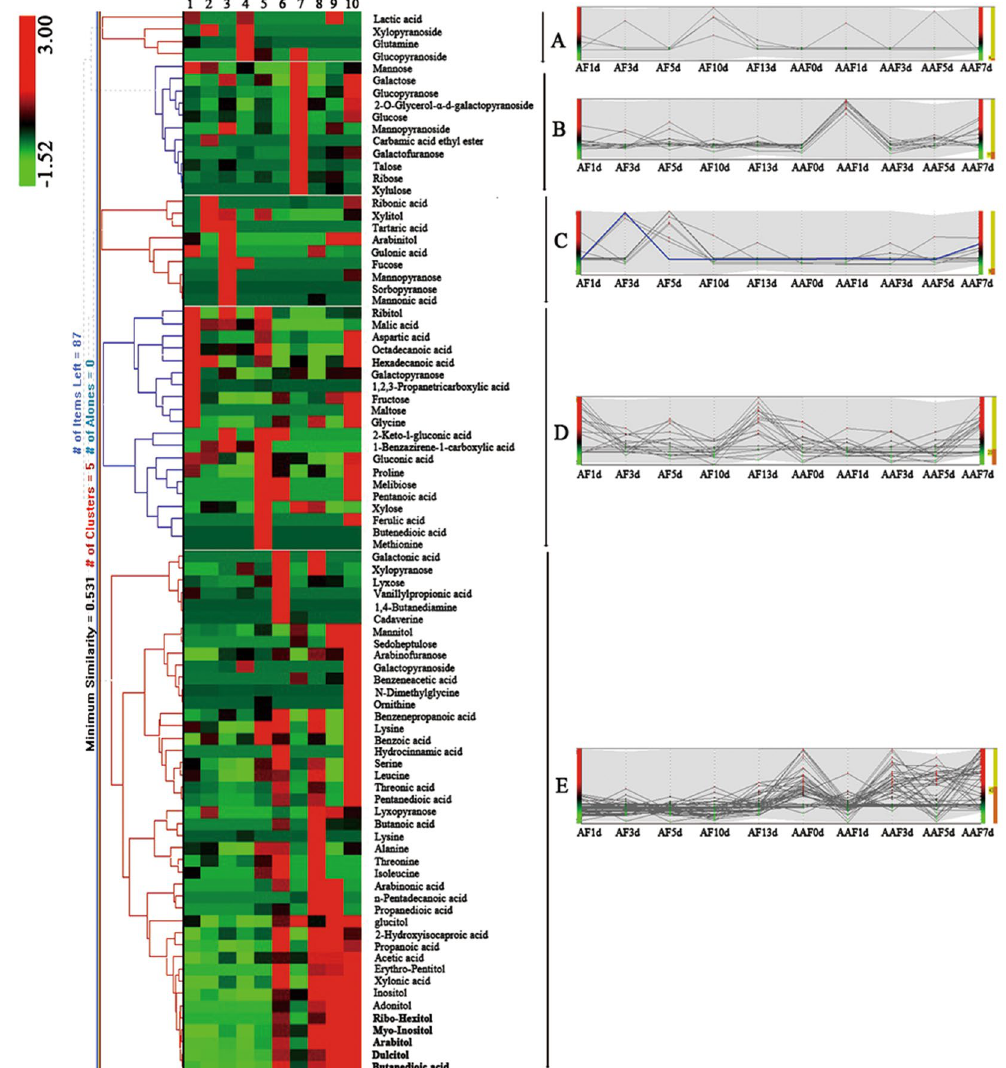
Figure 4. Hierarchial clustering analysis of 87 nonvolatile metabolites in different fermentation stages. Each row represents different nonvolatile compounds, and each column represents the fermentation time of SAV. Numbers 1–5 represent 1 day to 12 days of alcohol fermentation. Numbers 6–10 represent 0 day to 7 days of acetic acid fermentation. The color scale represents the relative concentration of different compounds. All metabolites are divided into five groups (A, B, C, D and E) according to their change